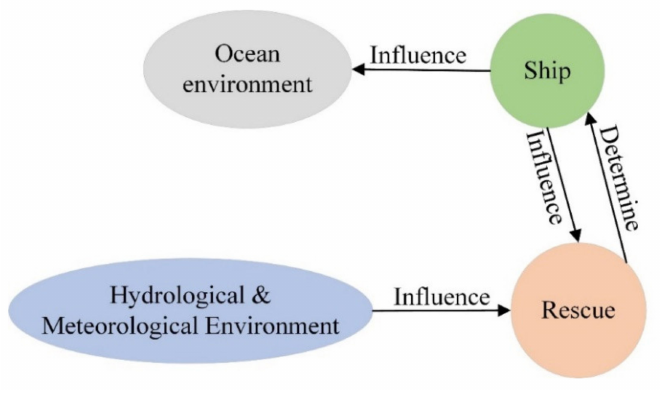
Figure 2. Ship–environment–rescue logical